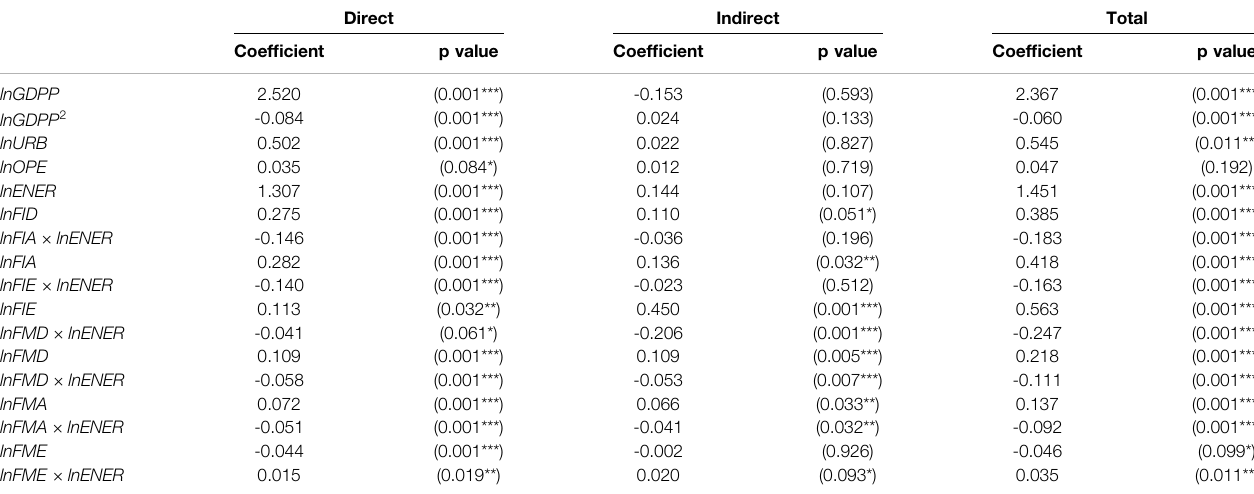
TABLE 9 | Marginal effects of the CO 2